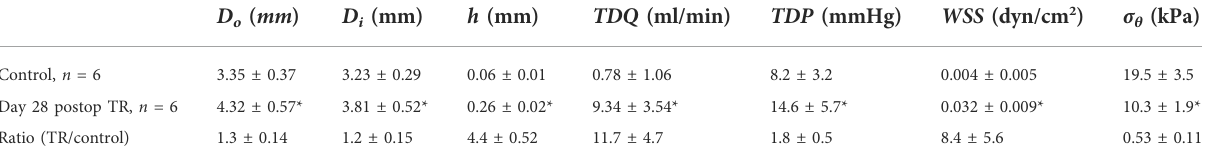
TABLE 2 The changes of morphometric, lympho-dynamic, and biomechanical parameters of the TD due to TR.